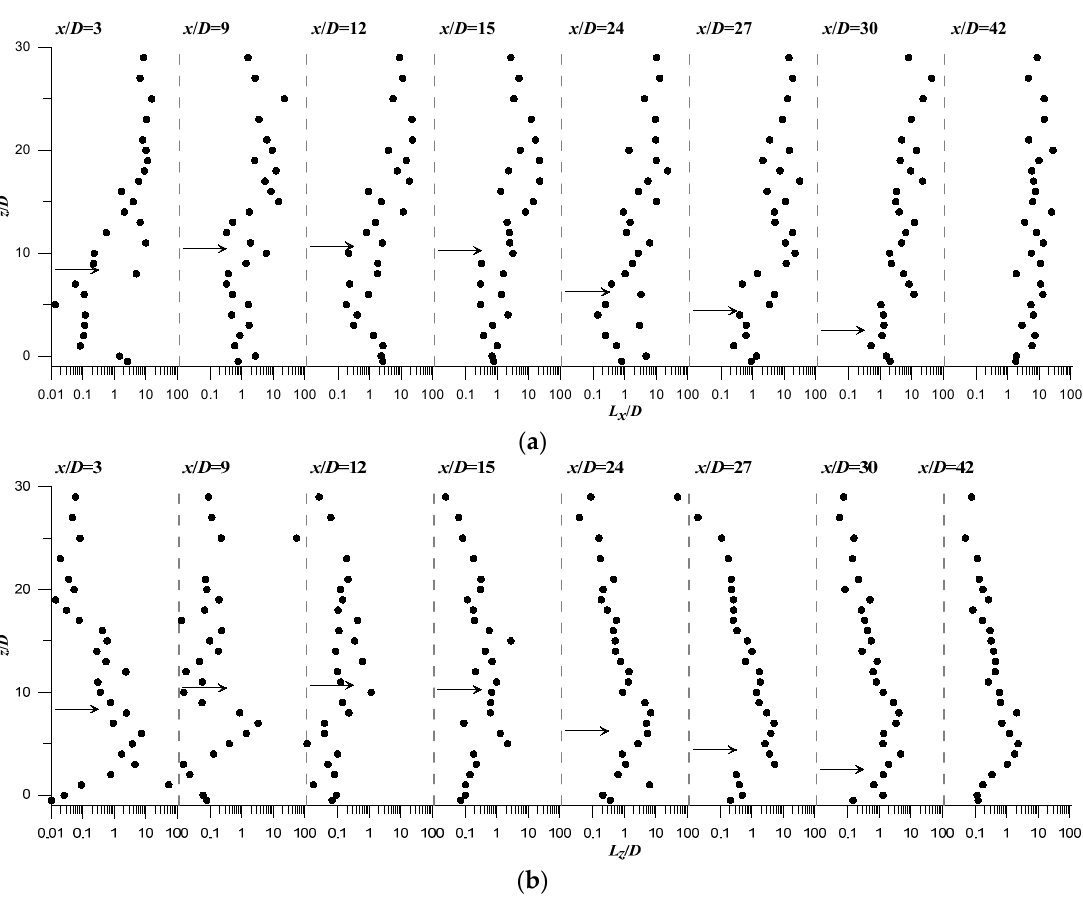
Figure 13. Vertical profiles of the normalized turbulent length scales at different downstream positions x / D at the plane of flow symmetry ( y = 0) of run R1: ( a ) L x / D ; ( b ) L z / D . The horizontal arrow on the profiles indicate the position of the jet axis.